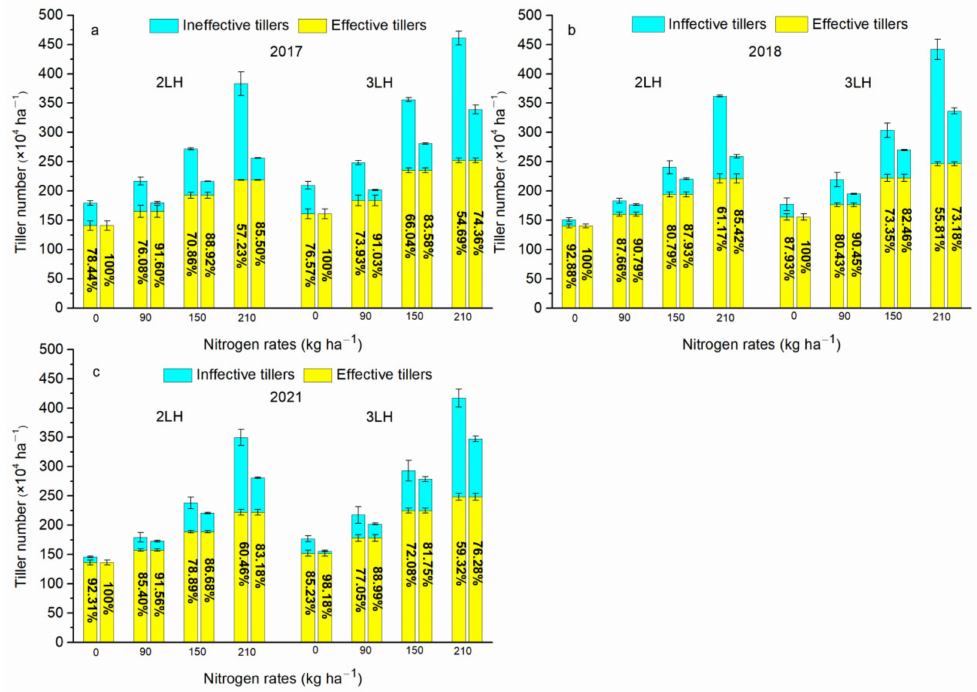
Figure 3. Tillering characteristics of two rice types with different nitrogen rates in 2016 ( a ), 2017 ( b ), and 2021 ( c ). 2LH: two-line hybrid rice; 3LH: three-line hybrid rice. The left side of the two adjacent bars represents jointing stage, and the right side represents heading